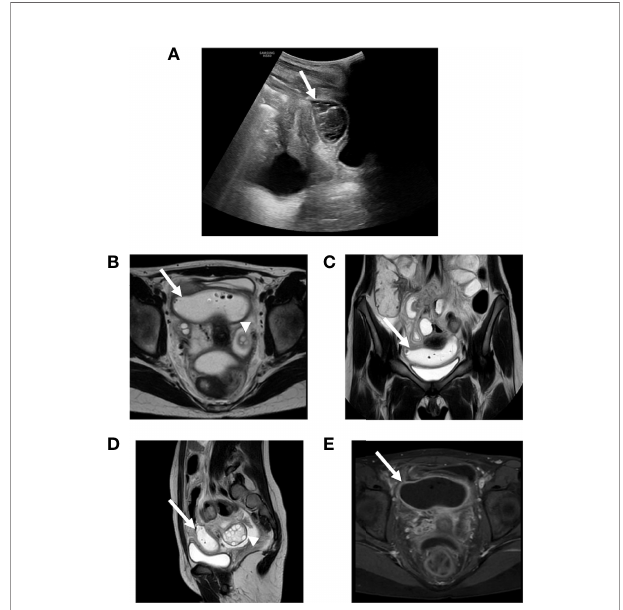
FIGURE 1 | (A) Abdomen ultrasound showing an encapsulated abscess between bladder and uterus (arrow). (B – E) Abdomen MRI showing a pelvic large fl uid- fi lled abscess (arrows) with air bubbles such as for bowel perforation ( B – D : T2 weighted) with parietal contrast enhancement ( E : T1 weighted) and normal adnexal region